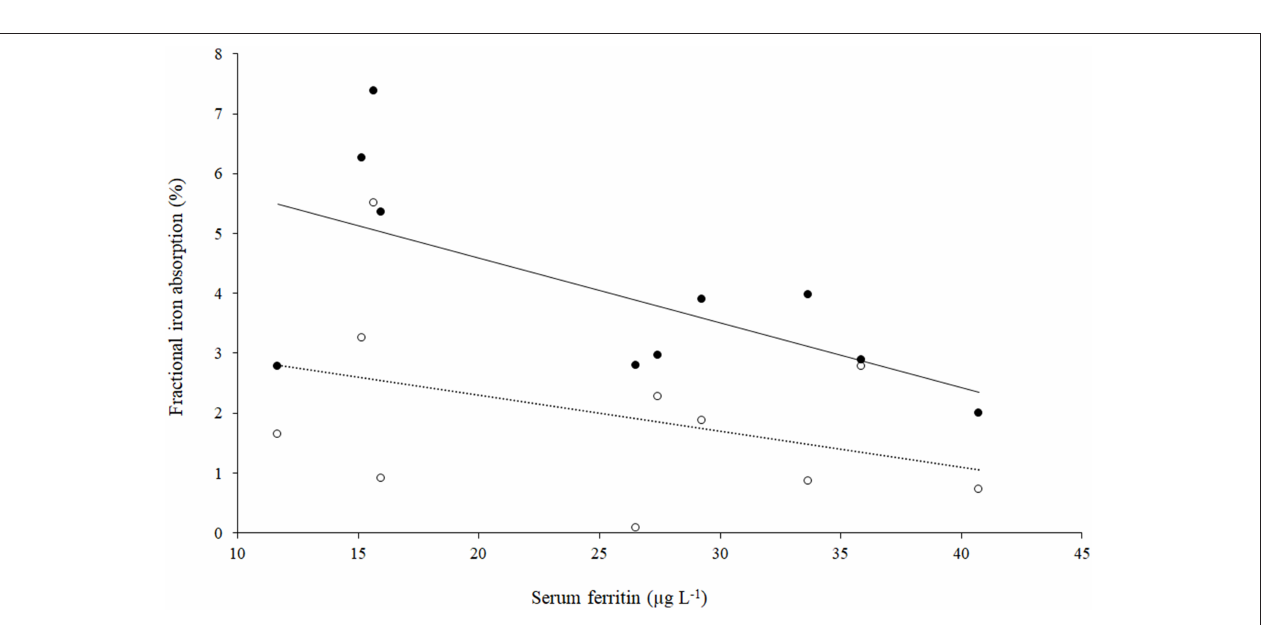
FIGURE 5 | Scatter plot of iron absorption against serum ferritin in low GPA accession GE 2358 and high GPA accession GE 1004 ( n = 10). Filled circles: Low GPA content finger millet accession; r 2 = 0.38, p = 0.056, iron absorption = ( − 0.108 × serum ferritin) + 6.75. Open circles: High GPA content finger millet accession. r 2